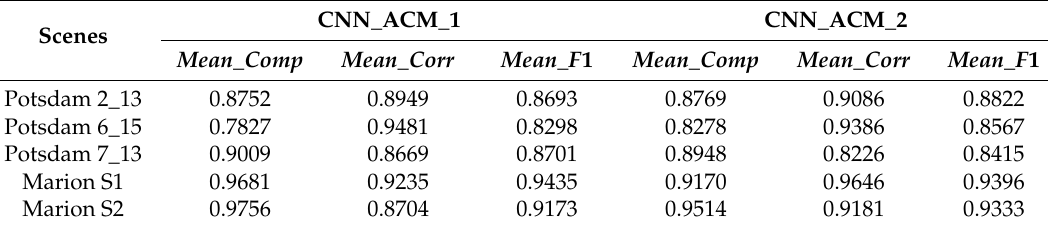
Table A3. Accuracies of the proposed method at the object